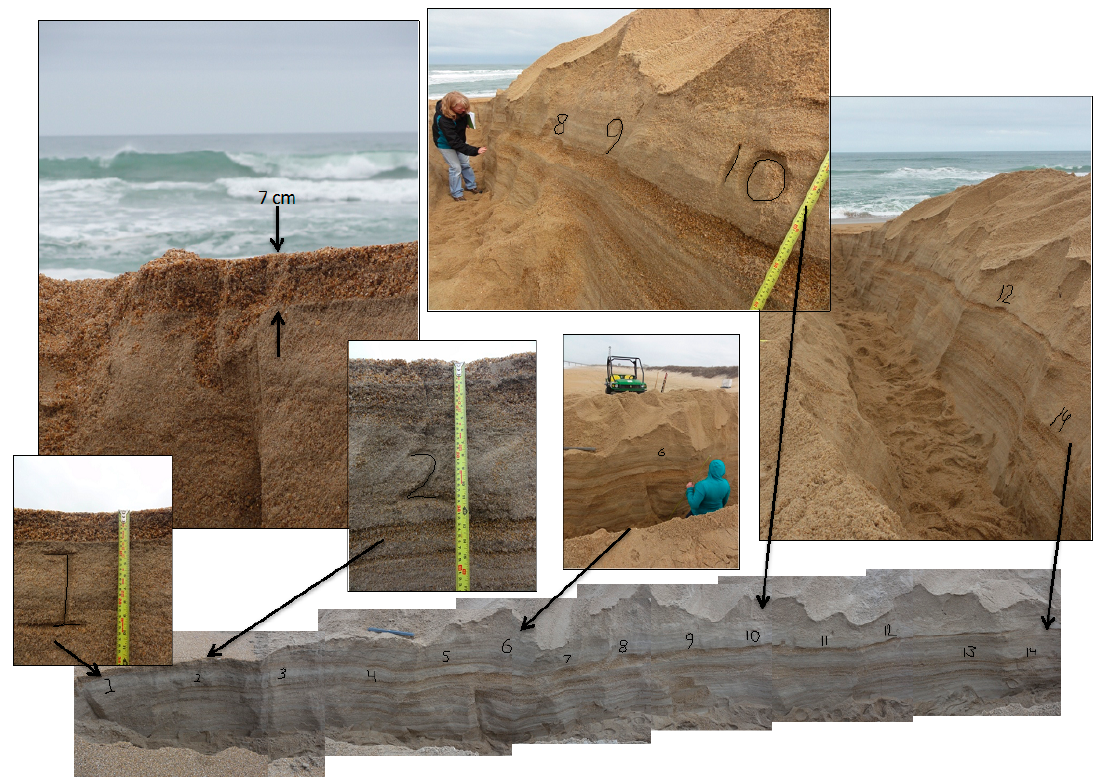
Figure 6. Images of the cross ‐ shore trench that was dug near the end of the experiment. The bottom image is a compilation of multiple images, showing the whole trench. The other images show details (like layer thickness and extent) at various locations in the trench. Note the numbers scratched in the sand wall (and outlined in black) of the trench approximately every meter for reference.